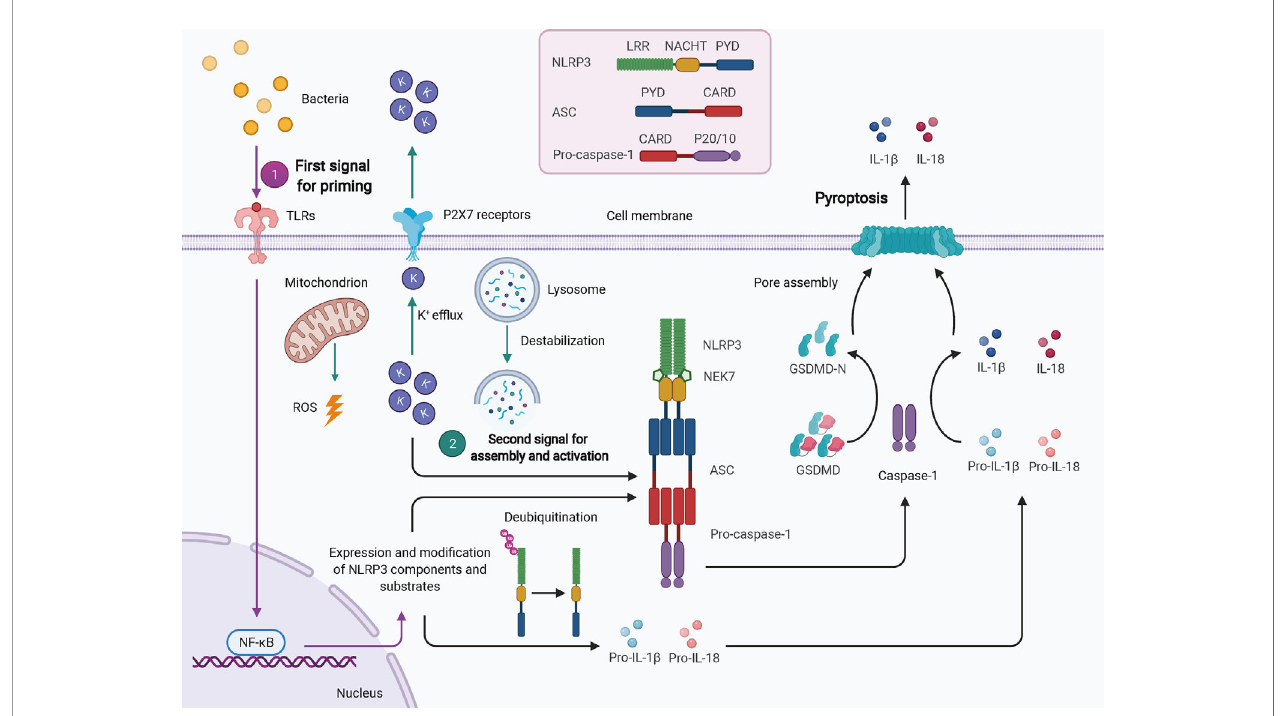
FIGURE 1 | Schematic of NLRP3 in fl ammasome activation. In most cell types, activation of the NLRP3 in fl ammasome typically requires two signals. The fi rst signal for priming (purple arrows) may result from TLR-mediated NF- k B-dependent transcriptional signaling, leading to increased expression and post-translational modi fi cation of NLRP3 in fl ammasome components and substrates. The second signal (green arrows) comes from a plethora of stimuli and agonists, such as ROS, potassium ef fl ux, and lysosomal destabilization, which converge to increase cellular stress. NLRP3 oligomerizes and interacts with pro-caspase-1 with the help of ASC via homotypic interactions of PYD-PYD and CARD-CARD. The activated caspase-1 processes pro-IL-1 b and pro-IL-18 to mature IL-1 b and IL-18 and cleaves GSDMD to GSDMD-N, which inserts into the membranes to form pores, thereby leading to pyroptosis. ASC, apoptosis-associated speck-like protein containing a CARD; CARD, caspase activation and recruitment domain; GSDMD, gasdermin D; LRR, leucine-rich repeat; NEK7, NIMA-related kinase 7; NF- k B, nuclear factor- k B; PYD, pyrin domain; ROS, reactive oxygen